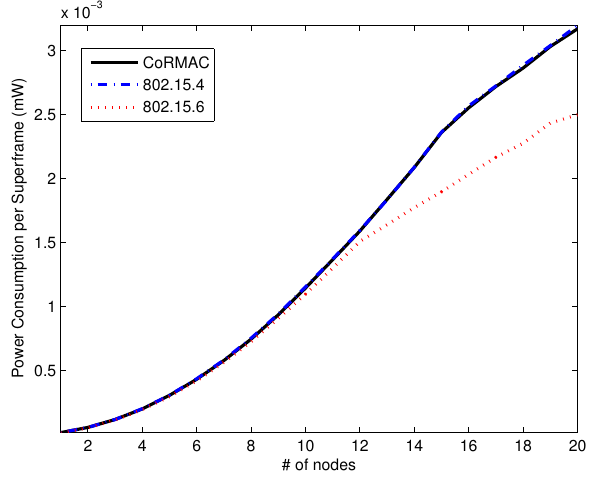
Figure 12. The average power consumption per superframe vs. the number of